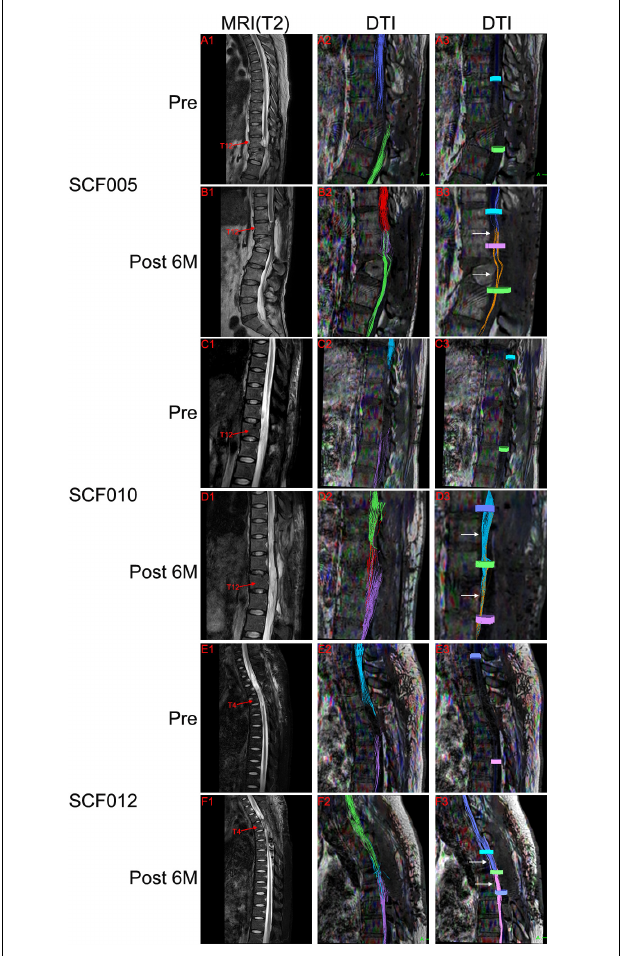
FIGURE 8 | Representative neuroimages. Preoperative T2-weighted MRI scans showed spinal cord injury ( A1,C1,E1 ), and DTI showed complete disruption of the spinal cord fibers ( A2,A3,C2,C3,E2,E3 ). Postoperative T2-weighted MRI scans and DTI showed the autotransplanted sural nerve in the original spinal cord injury area ( B1,B2,D1,D2,F1,F2 ). DTI showed restoration of neural connection at the two sites of transection (white arrows in B3,D3,F3 ). The colors of the fibers were automatically generated by the DTI system of MRI, with no practical significance. Pre, Preoperatively; Post 6M, 6 months postoperatively.